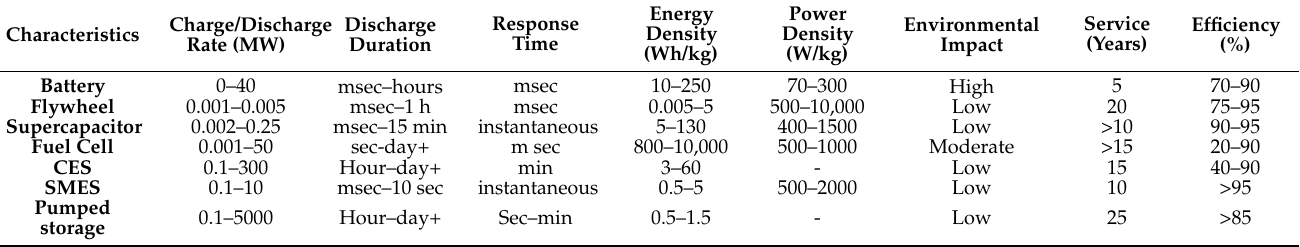
Table 2. Different energy storage systems in